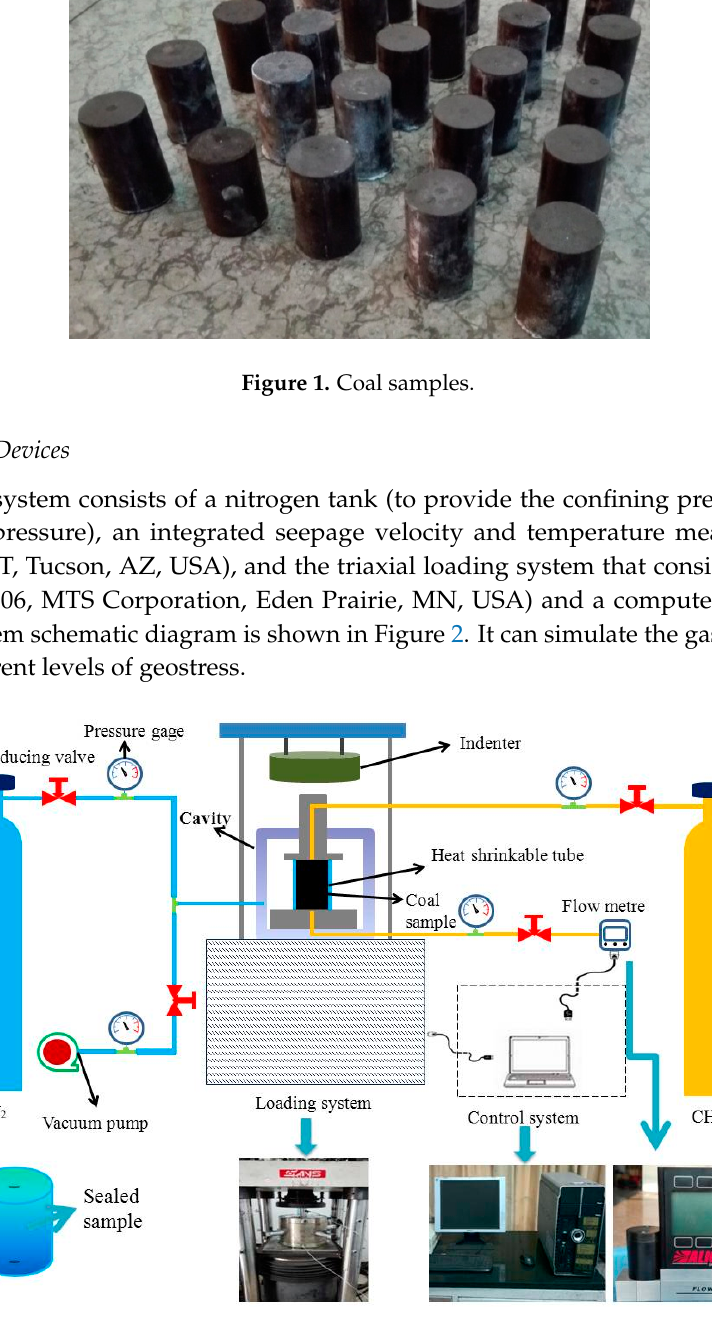
Figure 2. Schematic diagram for the experimental system.